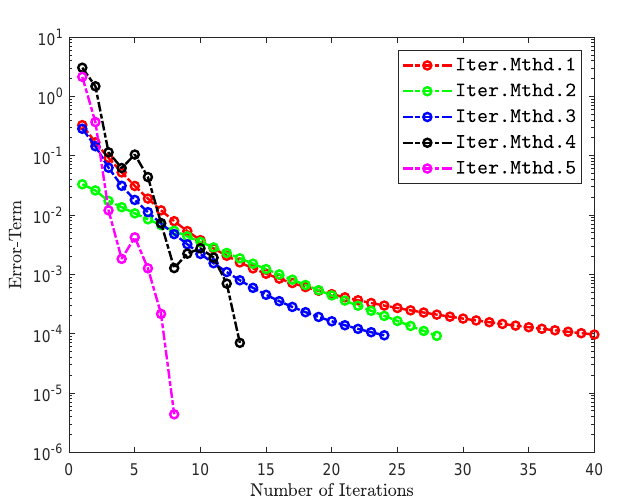
Figure 1. All techniques are computationally examined while s 0 = ( 1,1,1,1,1 ) T